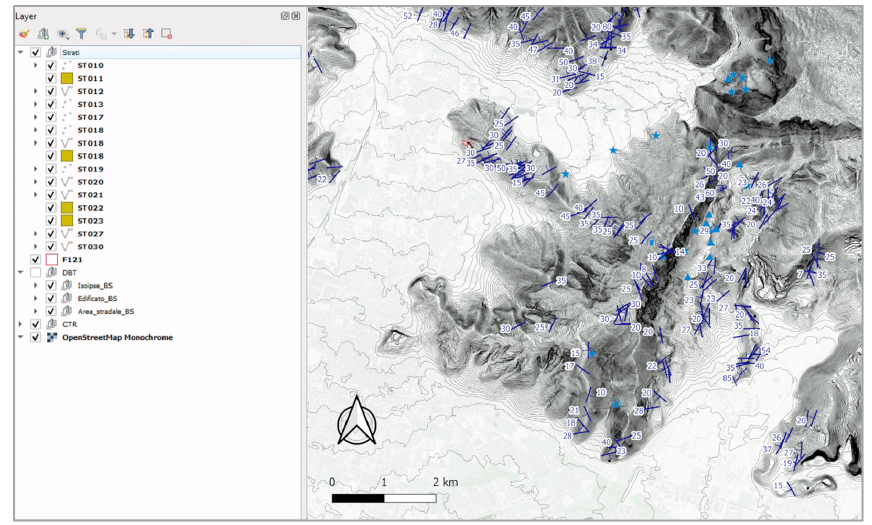
Figure 3. Example of the integrated GIS project view. OSM is used as the